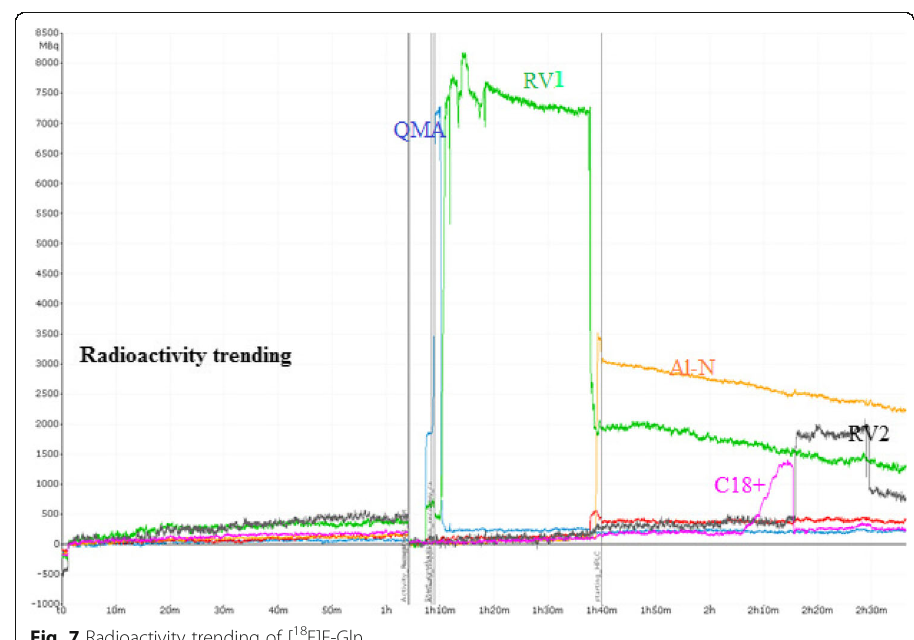
Fig. 7 Radioactivity trending of [ 18